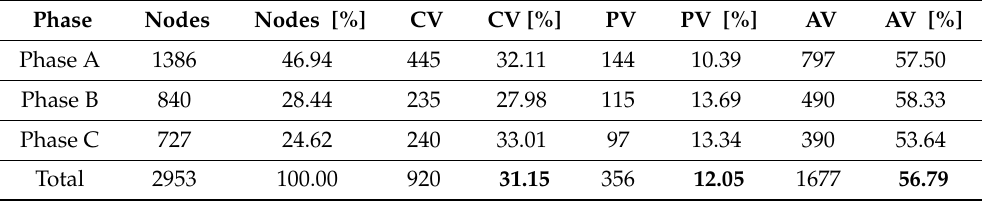
Table 7. Node voltage rating at Feeder